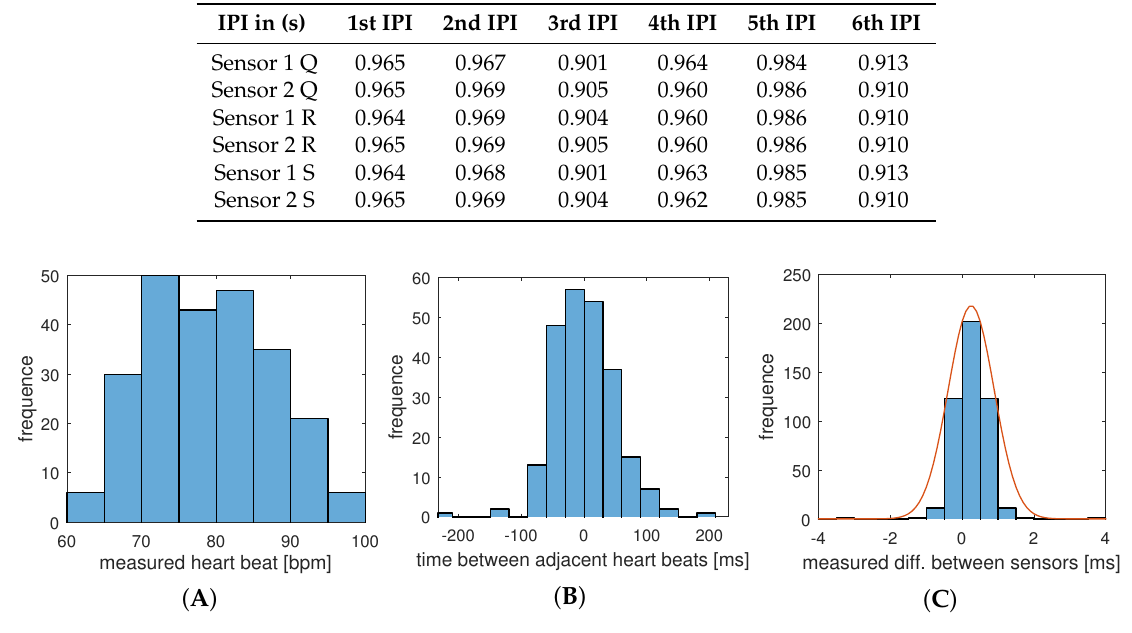
Figure 11. Distribution of ( A ) measured IPIs; ( B ) difference between two adjacent measurements; and ( C ) measurement errors between